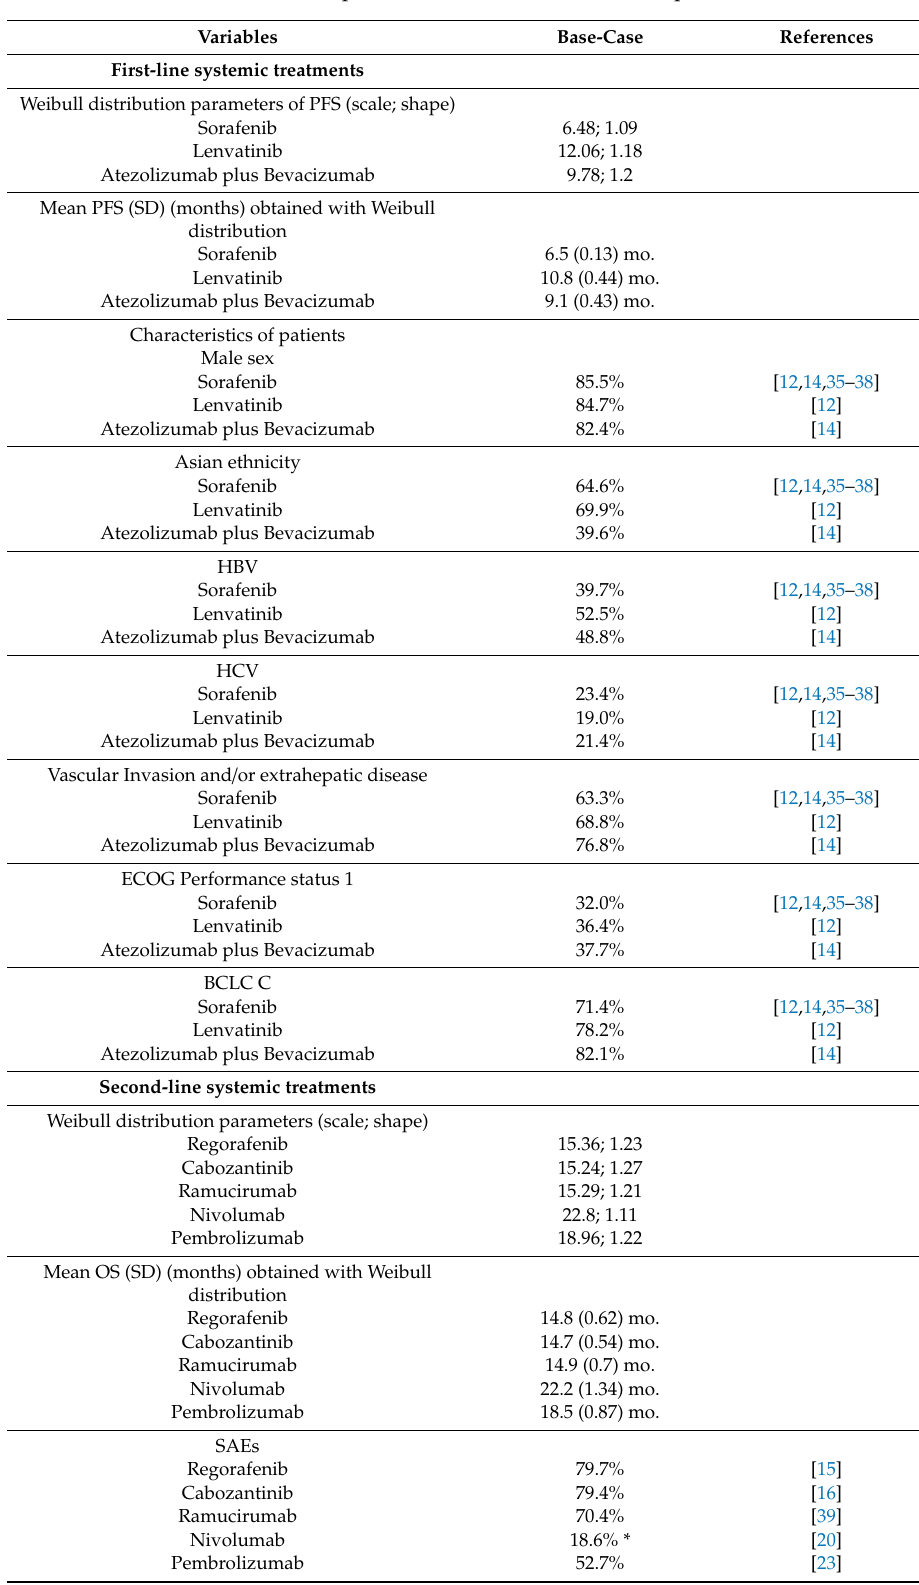
Table A2. Model parameters and characteristics of